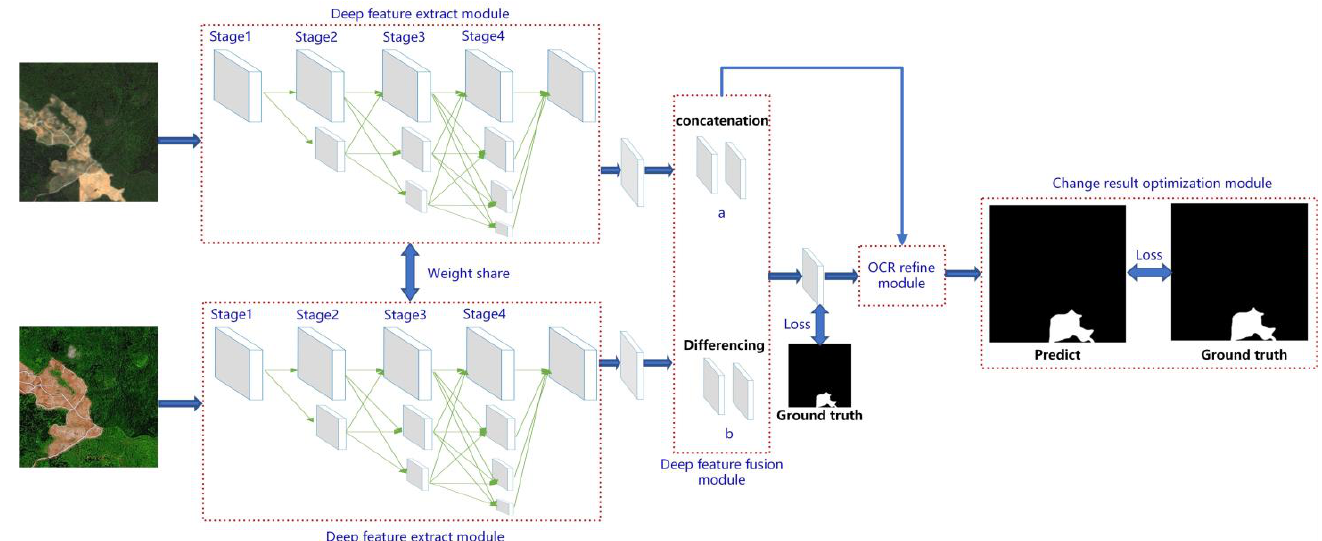
Figure 4. The architecture of the SiamHRnet-OCR.